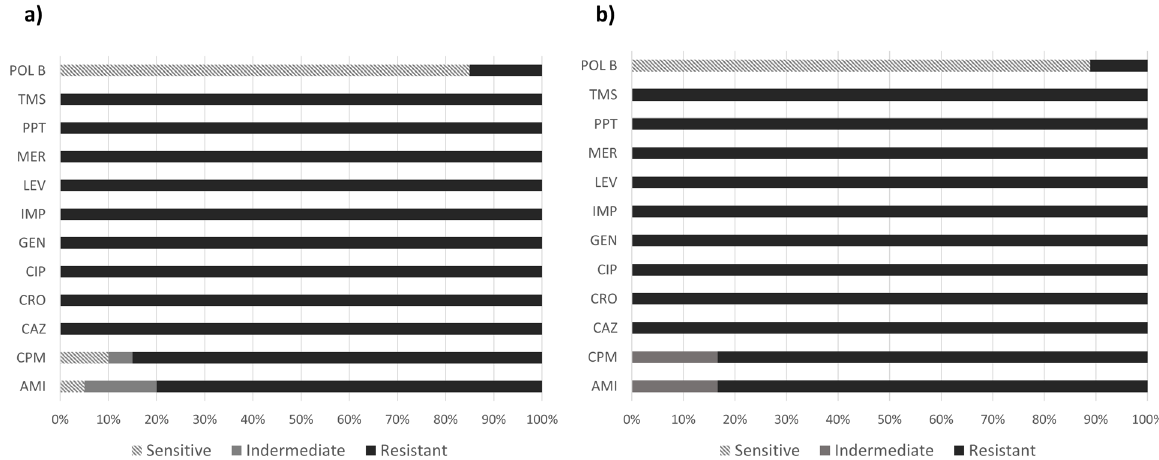
Figure 1. Percentage representation of antimicrobial susceptibility profiles of Acinetobacter spp. isolates in Recife – PE – Brazil. a) Infection isolates and b) Colonization isolates. AMI: amikacin; GEN: gentamycin; IMP: imipenem; MER: meropenem; CIP: ciprofloxacin; LEV: levofloxacin; CPM: cefepime; CAZ: ceftazidime; CRO: ceftriaxone; PPT: piperacillin/tazobactam; TRI/SUL: trimethoprim + sulfamethoxazole; POL B: polymyxin